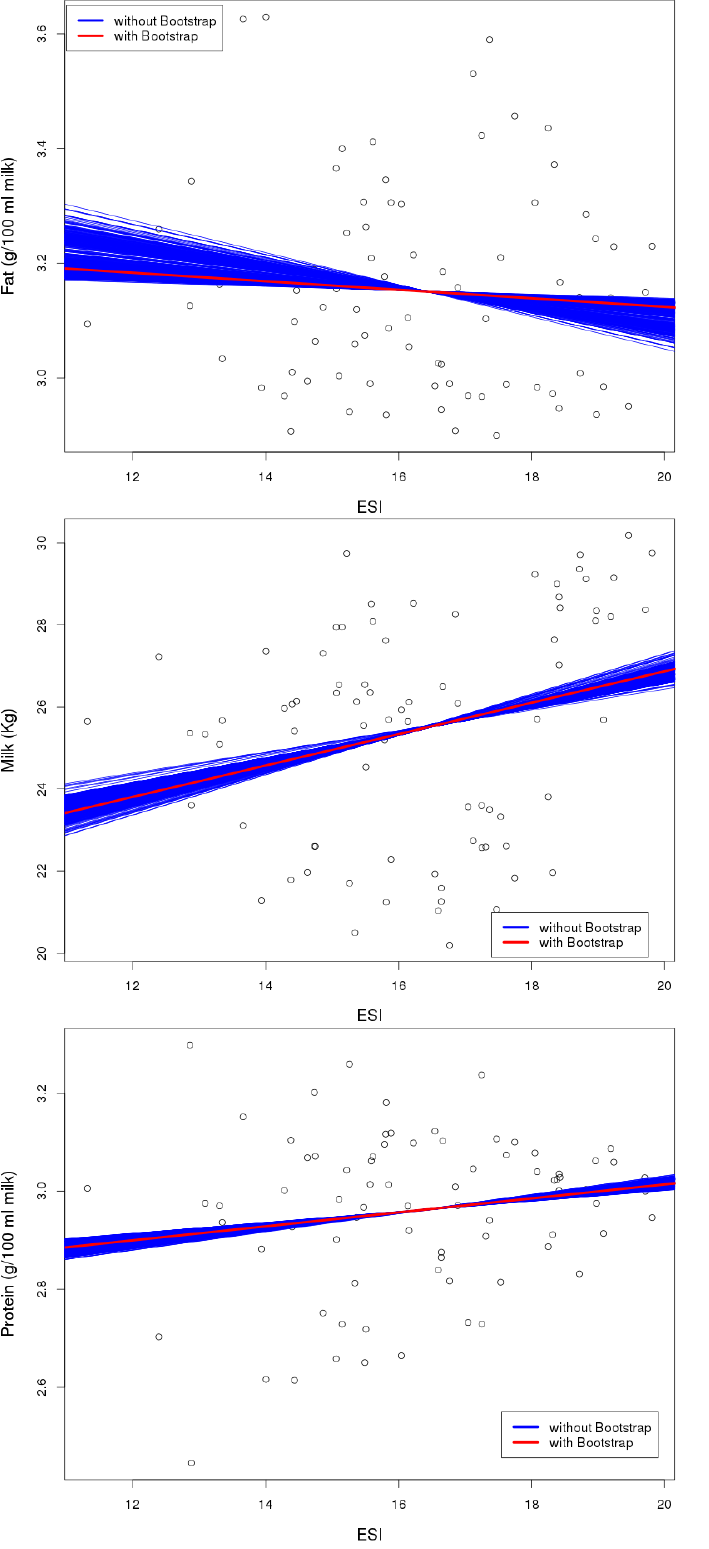
Figure 8. The best-fitted regression lines before (red line) and after 1000 bootstraps (blue lines) between milk components (fat, protein, and milk) and ESI in the